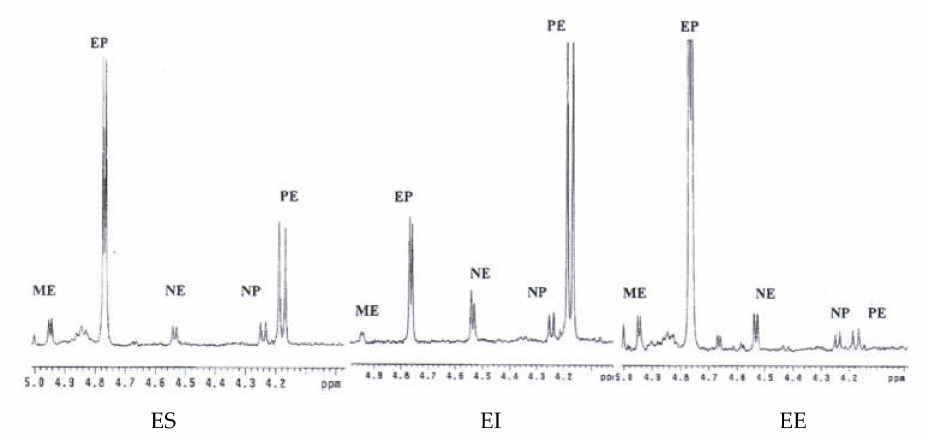
Figure 3. The H-1 signals of ephedrine alkaloids in the 1 H-NMR spectra of three Ephedra extracts [ E. sinica (ES), E. intermedia (EI), and E. equisetina